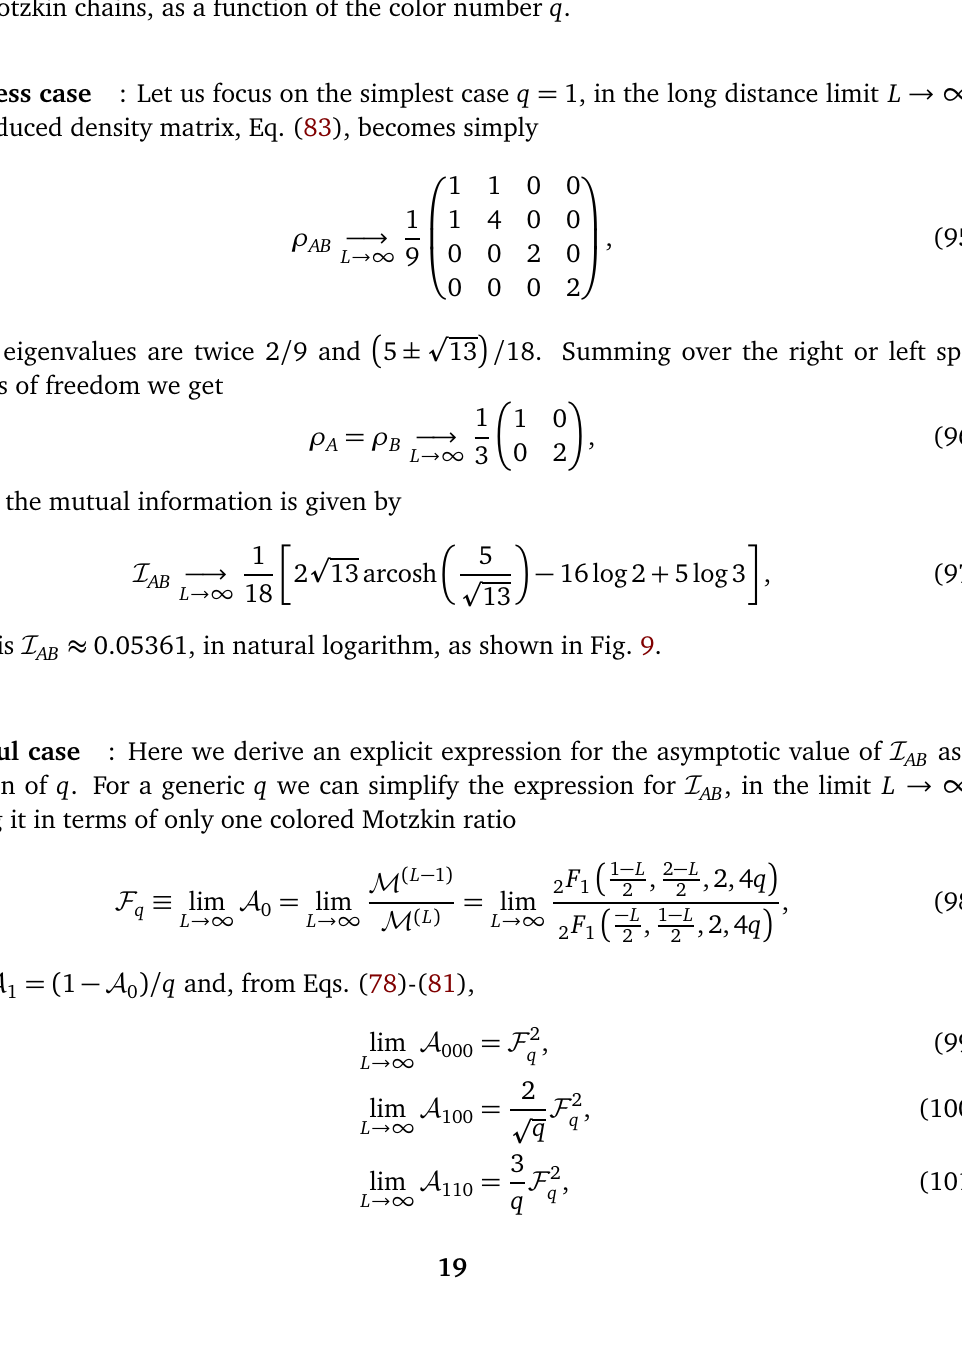
Figure 9: (Left) Mutual information between two spins at the edges of colorful Motzkin chains, as a function of the size L , for different values of q . (Right) Mu- tual information at long distance, L → ∞ between two spins at the edges of colorful Motzkin chains, as a function of the color number q